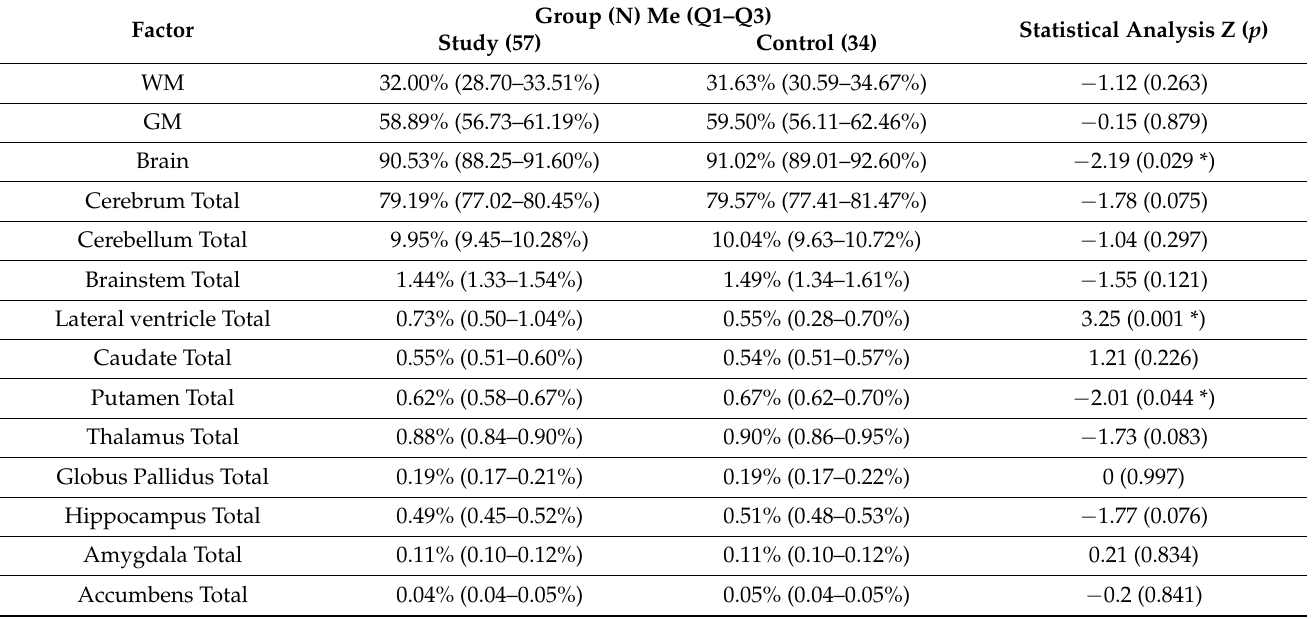
Table 3. Comparison of the volumes (% of IC) of particular brain structures between study and control groups. Descriptive statistics (N, median with lower and upper quartiles) with the statistical analysis (Mann–Whitney U test); statistically significant difference marked by “*” (asterisk).